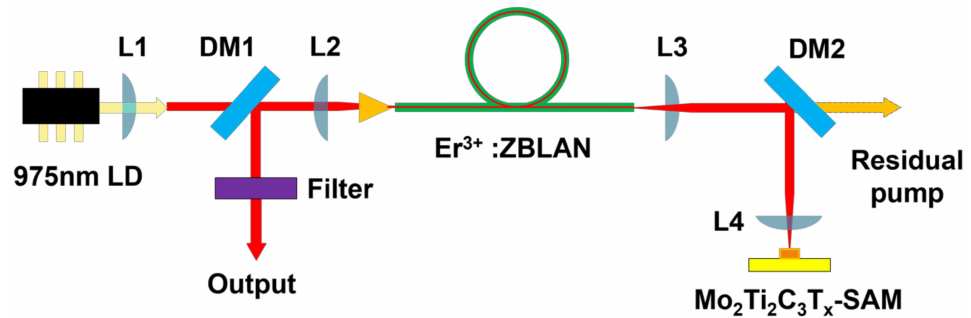
Figure 3. Schematic of the experimental setup for the passively Q-switched Er 3+ -doped ZBLAN fiber